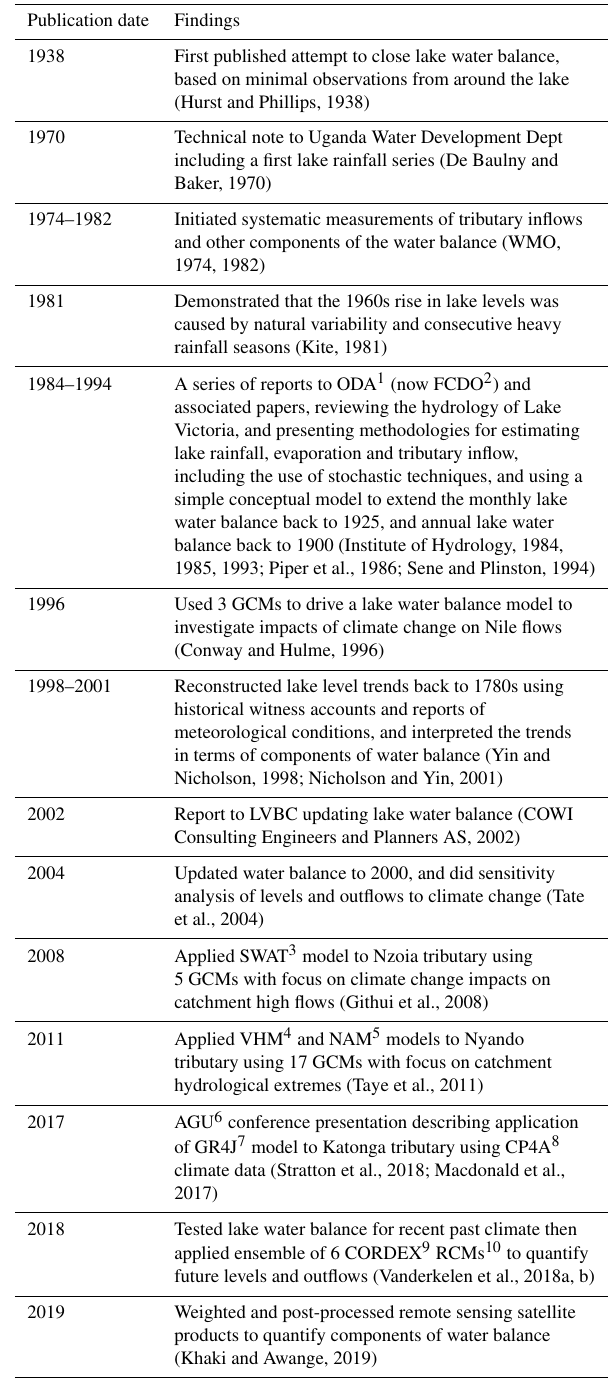
Table 1. Summary of key investigations of the water balance of Lake